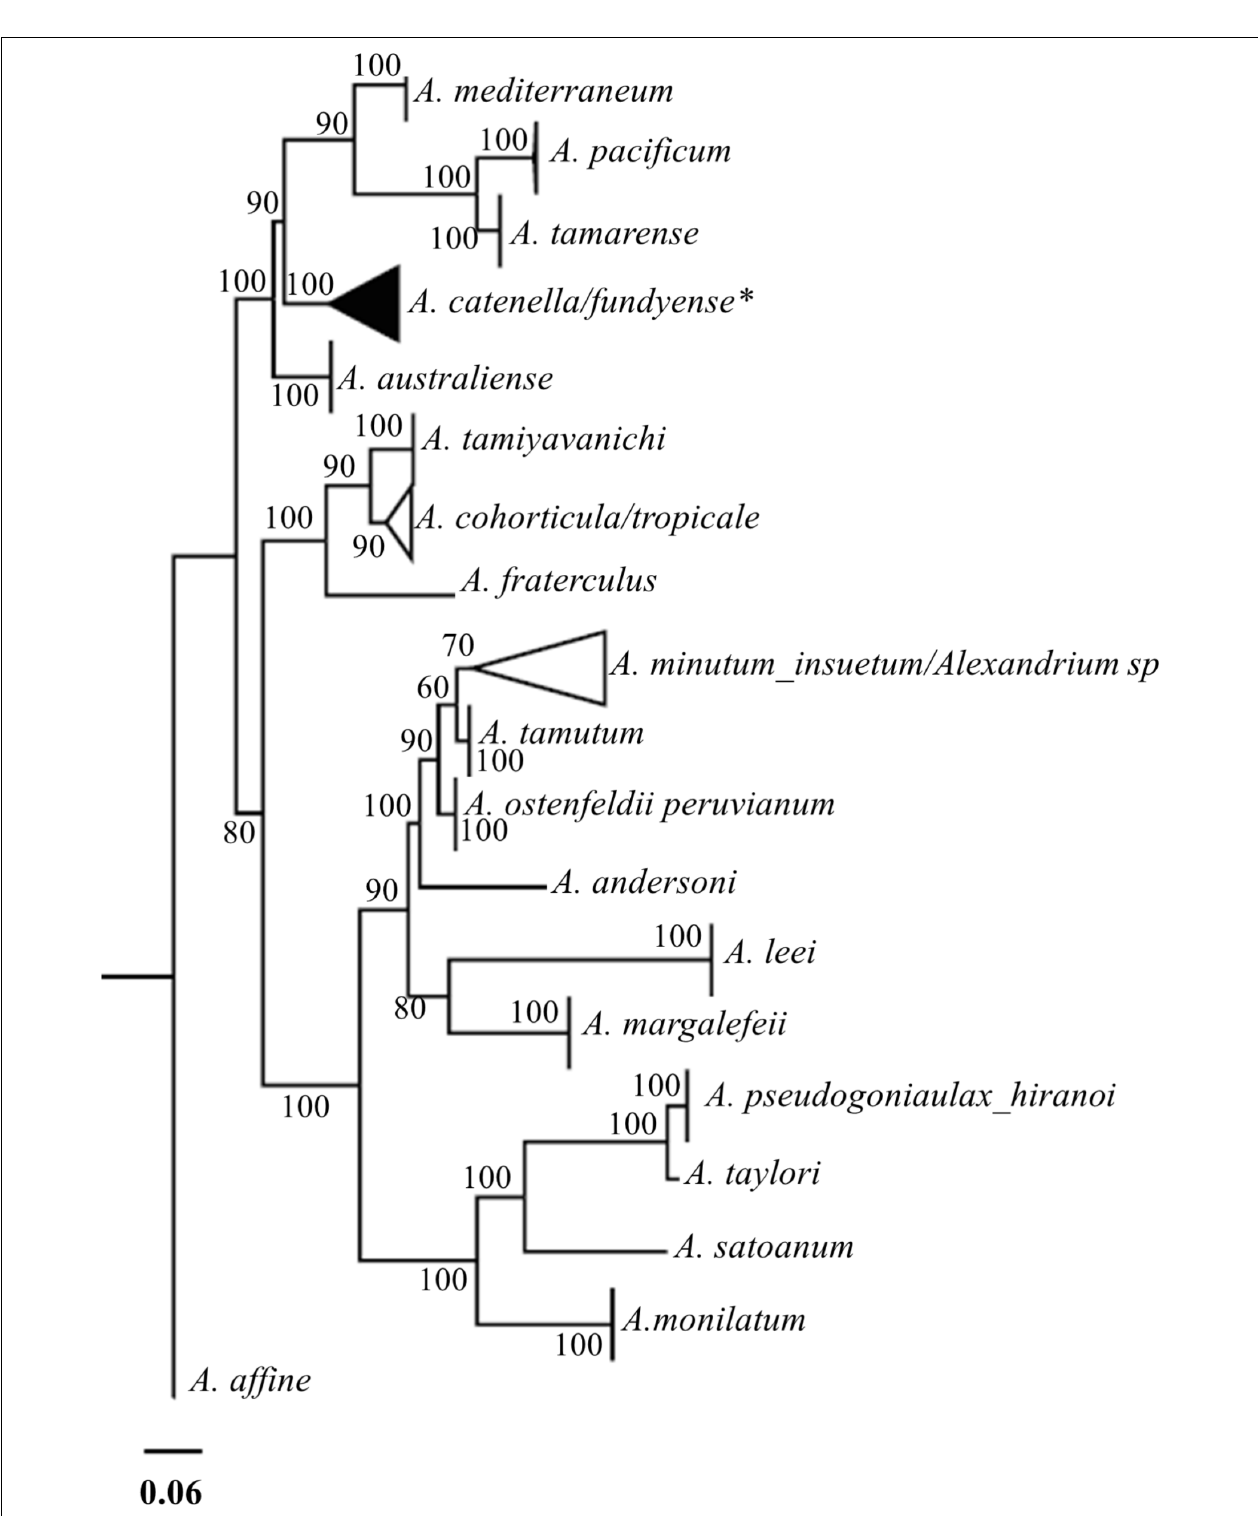
FIGURE 2 | Maximum likelihood phylogenetic reconstruction and bootstrap values using sequences generated by John et al. (2014) and sequences of the clones isolated from the northern limit of species distribution and from the 2016 bloom. Collapsed black triangle indicates the A. catenella clade (Group 1) and aggregation of all the clone sequences in this study. ∗ Sequences of the morphotype A. fundyense are also included in this clade.